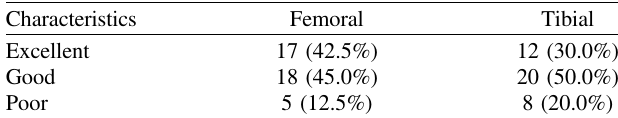
Figure 2. X -ray describing changes of the KJLO and the AJLO comparative to the ground. Table 2. Regeneration of articular cartilage.